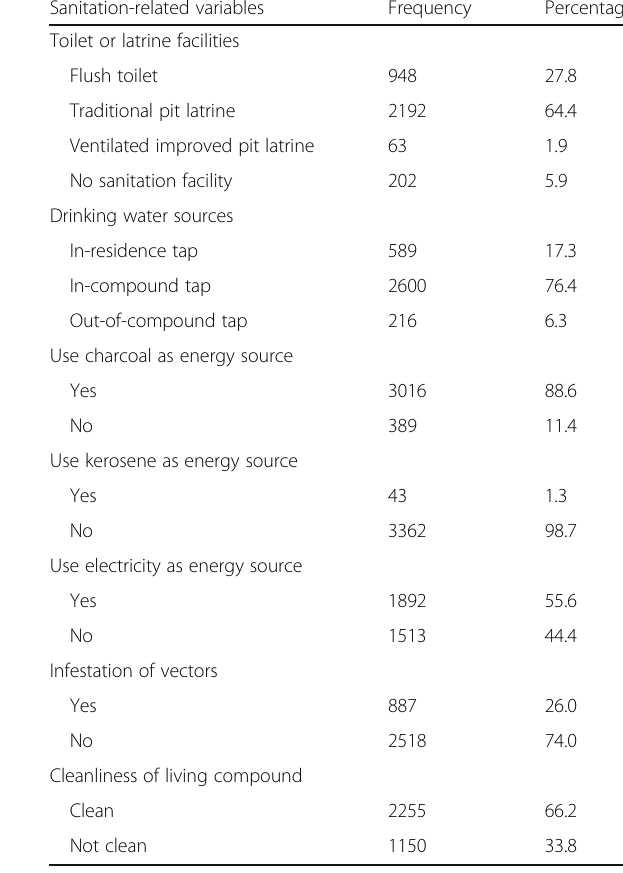
Table 3 Sanitation practices of study participants in